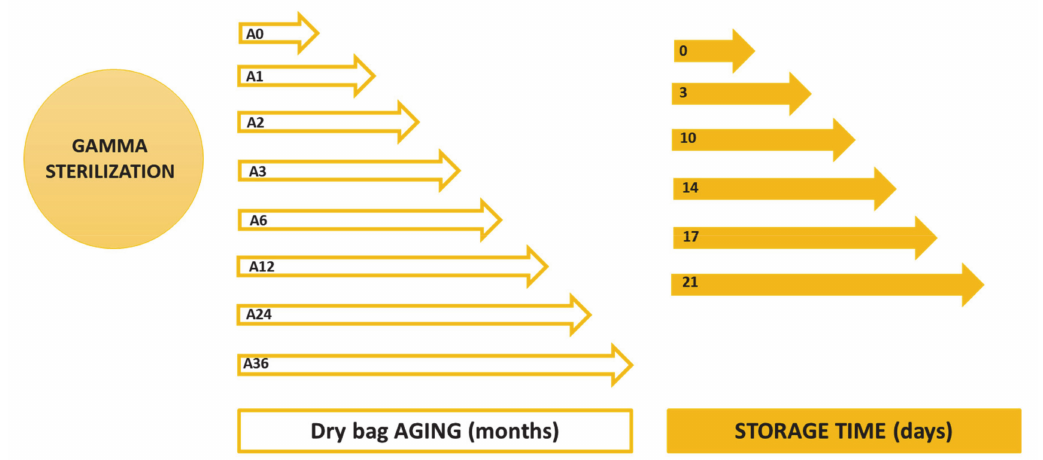
Figure 2. Aging and storage time